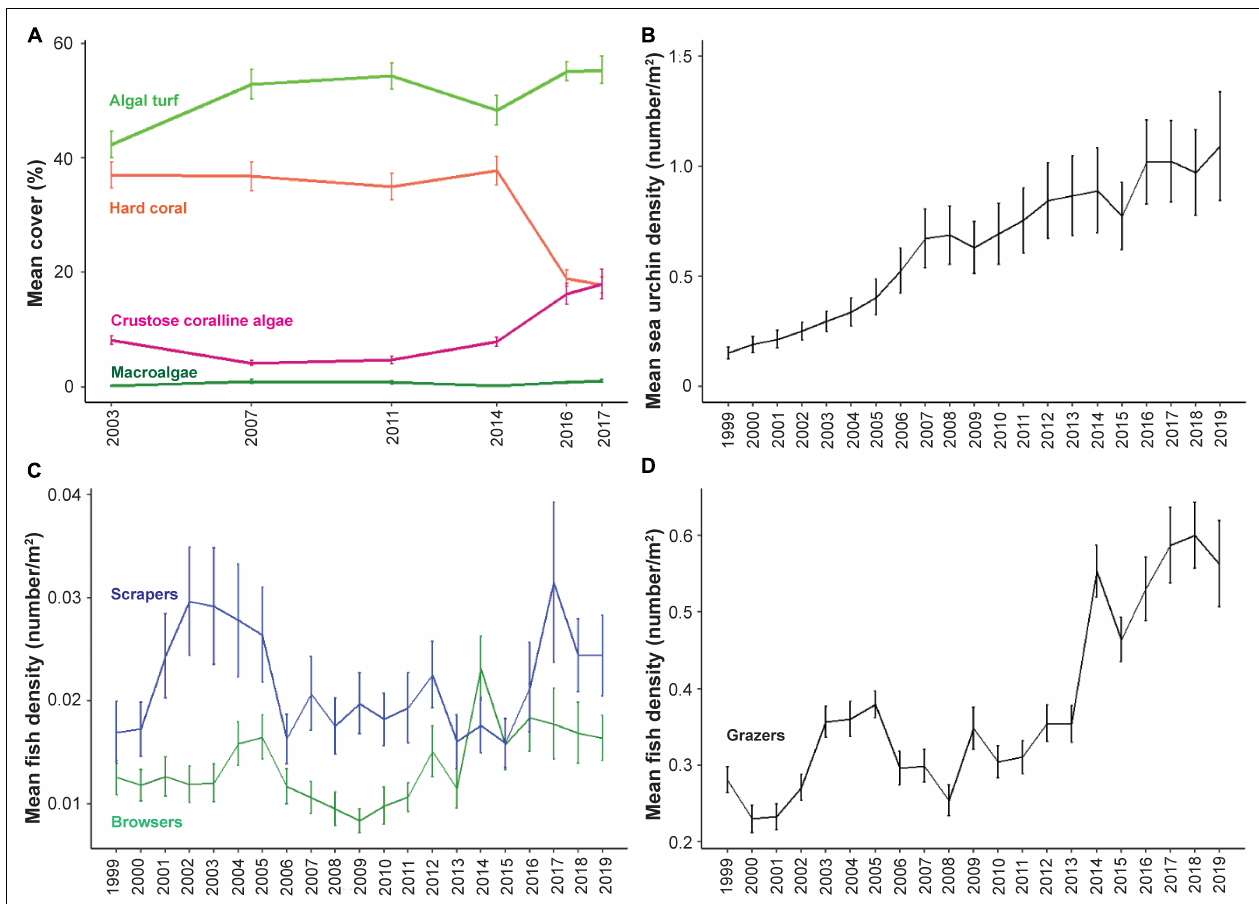
FIGURE 1 | Patterns of benthic cover and herbivore density over survey years. The mean density ± standard error for the 25 sites is shown for each year for benthic cover (A) , sea urchins (B) , scrapers and browsers (C) , and grazers (D) . Note, benthic analyses were only conducted for 6 years of the 20-year survey period.